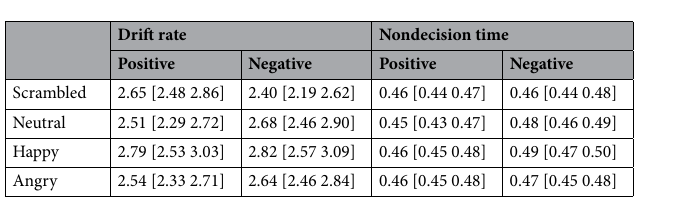
Table 2. Posterior estimates (mean and highest density interval) for the mean of the nondecision time and drift rate.